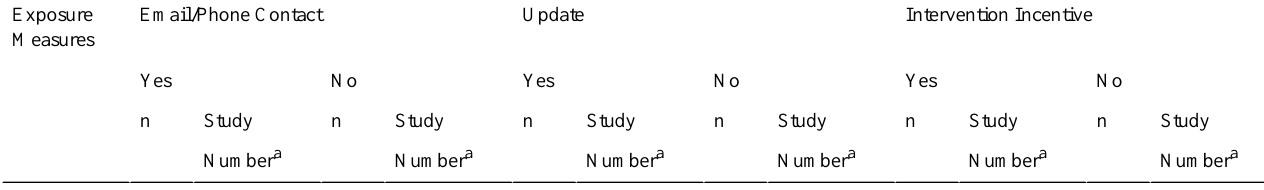
Table 4. Listing of studies by potential exposure-promoting elements (email/phone contact, updates, and intervention incentives) and the result of exposure measures